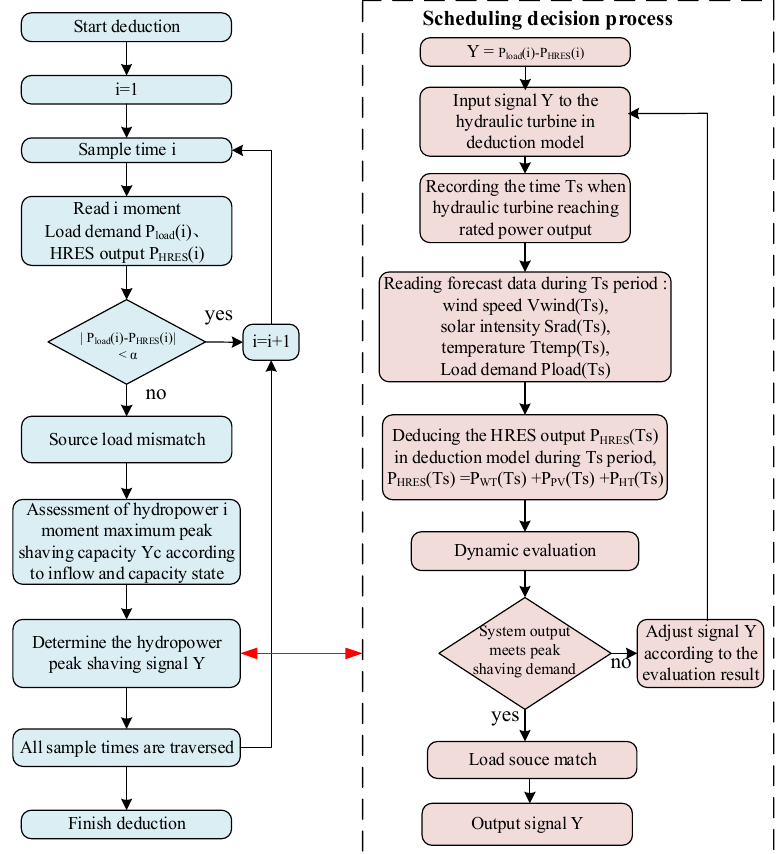
Figure 5. The flow of ultra-short-term real-time adaptive scheduling algorithm.